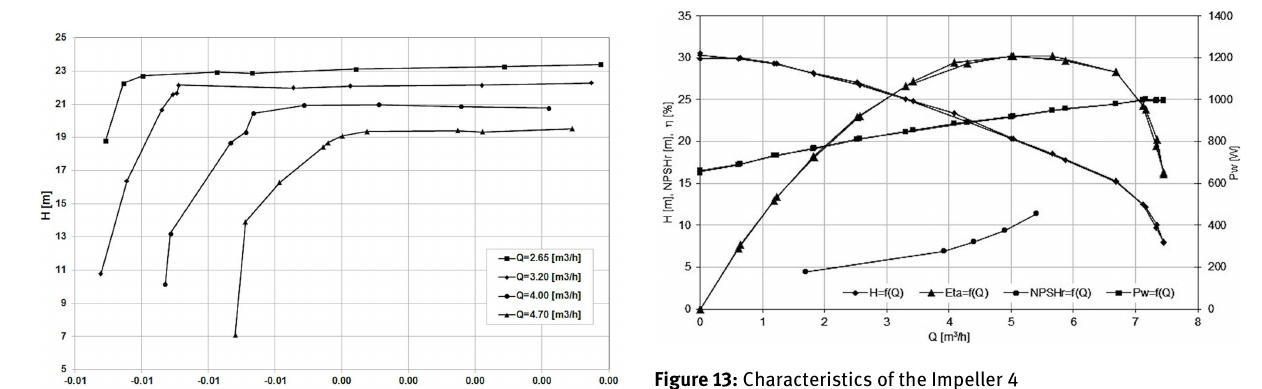
Figure 9: Characteristics of the Impeller 2